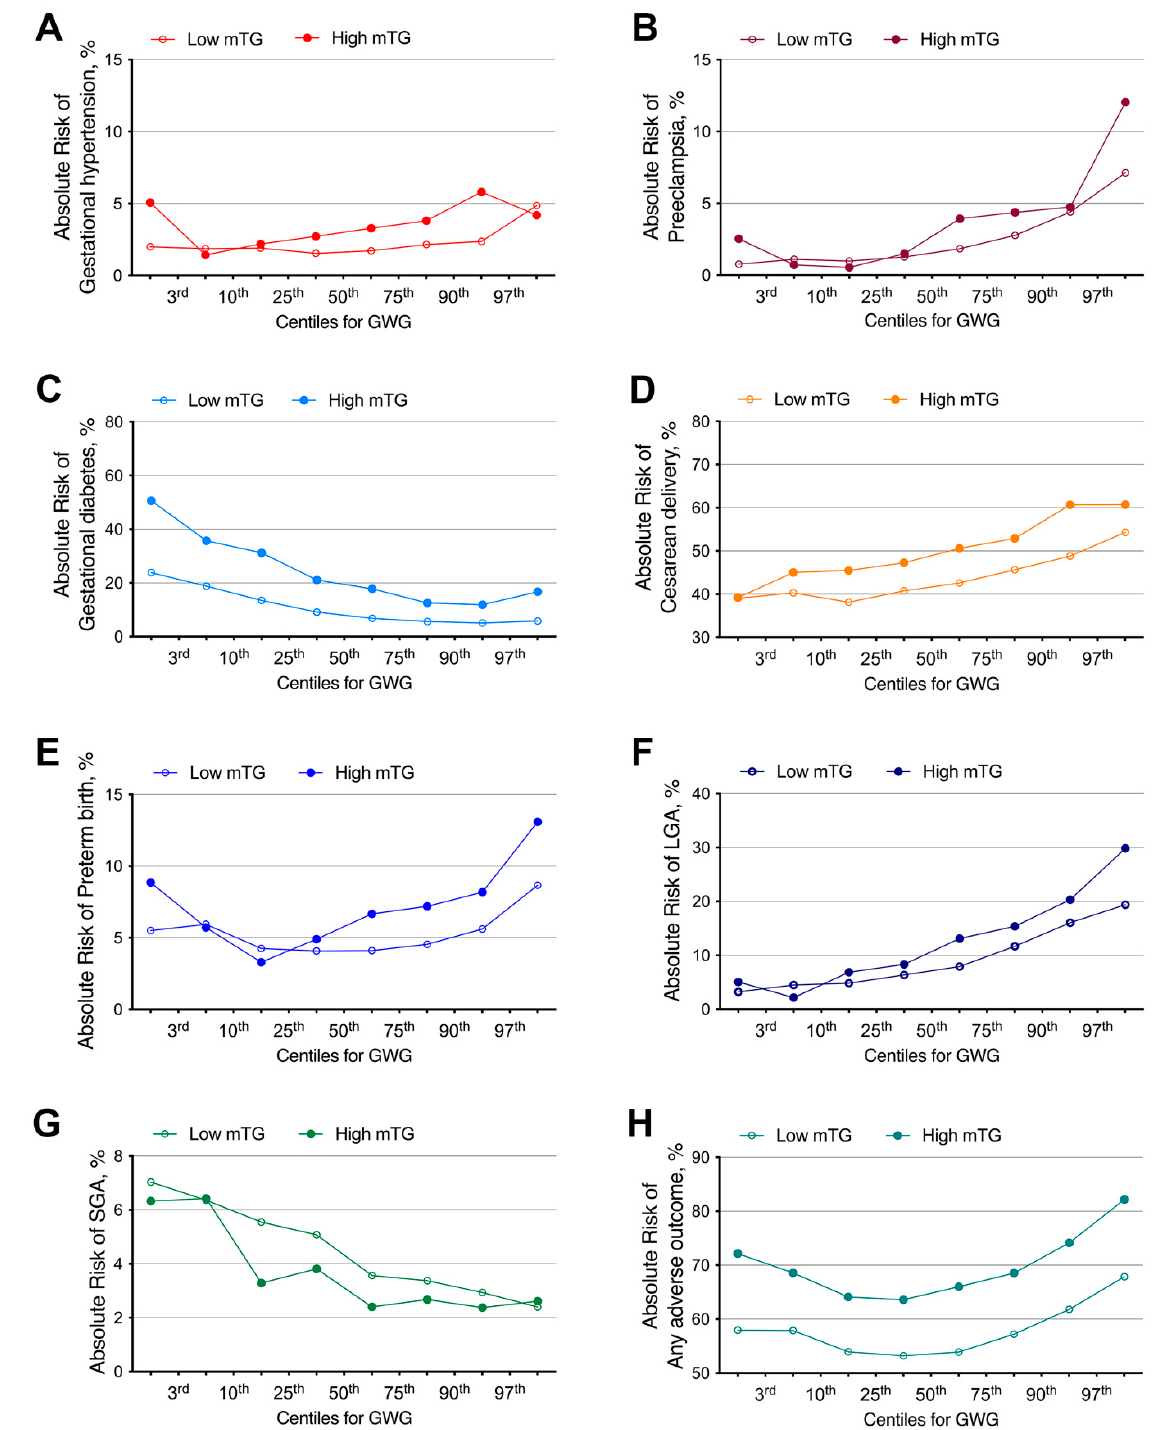
Figure 2. Association of gestational weight gain (GWG) percentiles with adverse pregnancy outcomes in low mTG and high mTG groups. Absolute risks of adverse pregnancy outcomes in different gestational weight gain (GWG) percentiles between low and high mTG group (A) Absolute risks of gestational hypertension; ( B ) Absolute risks of preeclampsia; ( C ) Absolute risks of gestational diabetes; ( D ) Absolute risks of cesarean delivery; ( E ) Absolute risks of preterm birth; ( F ) Absolute risks of LGA; ( G ) Absolute risks of SGA; ( H ) Absolute risks of any adverse